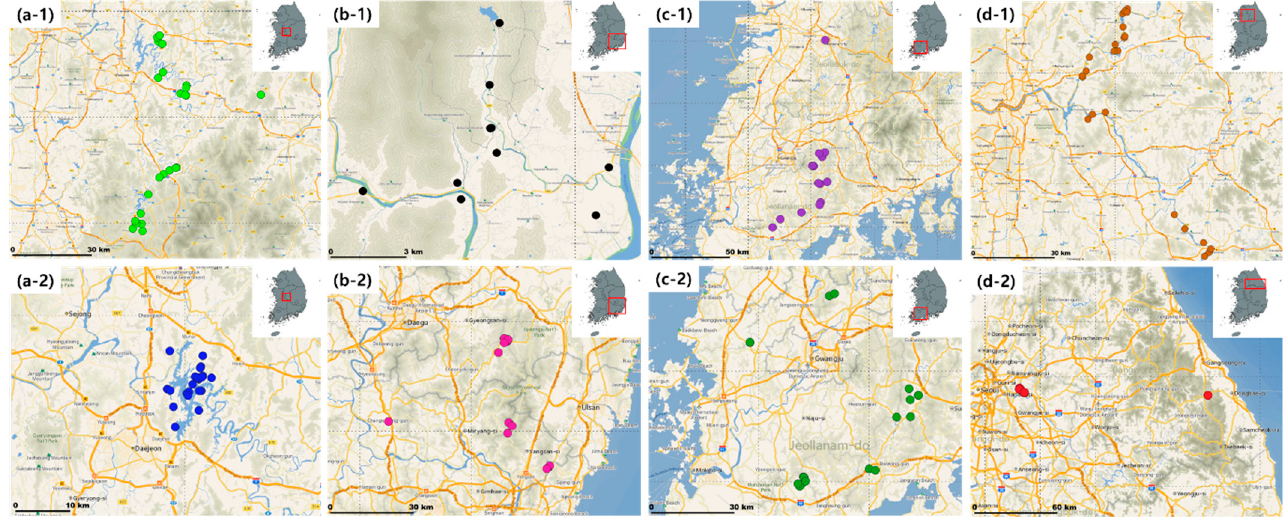
Figure 2. Study area with topsoil samples’ locations (the alphabet means the four major rivers in the Republic of Korea: ( a ) Geum River, ( b ) Nakdong River, ( c ) Yeongsan/Seomjin River, and ( d ) Han River. The waterfront area and drinking water protection zone are represented by ( 1 ) and ( 2 ) re ‐ spectively).